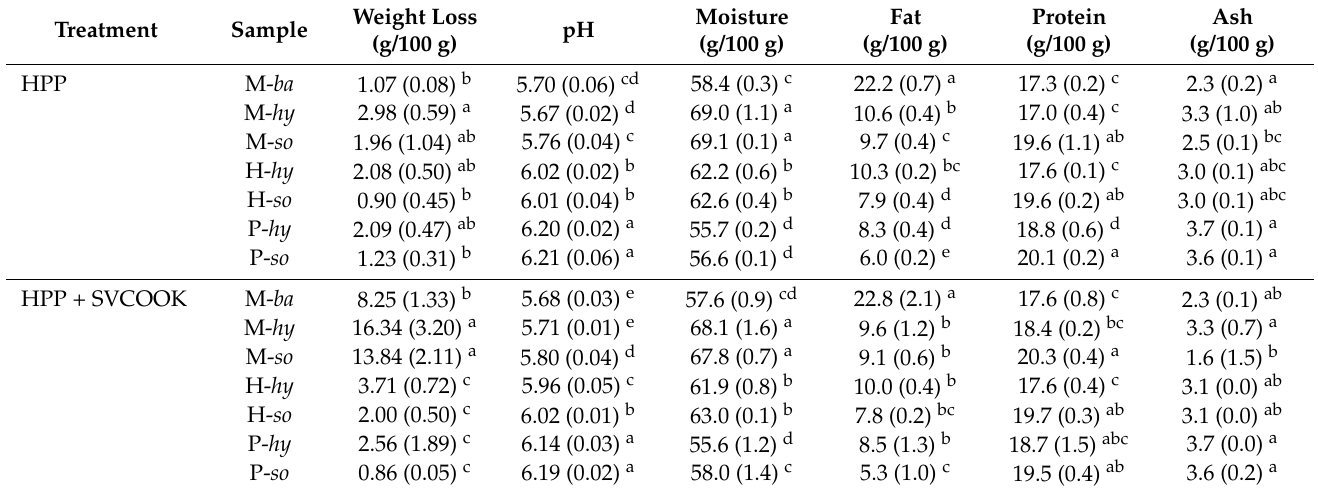
Table 1. Physicochemical characteristics of samples treated by HPP or HPP + SVCOOK according to protein matrix (M: meat-based patty; H: hybrid patty; P: plant-based patty) and fat replace- ment ( ba : backfat; hy : hydro-gelled emulsion; so : soya emulsion). Values are expressed as mean (standard